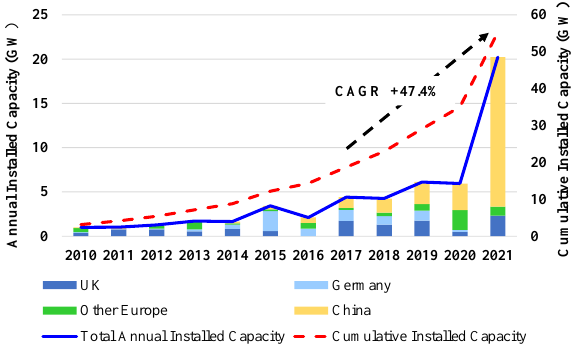
Figure 1. Annual installed offshore wind capacity (left axis) and cumulative capacity in GW (right axis) by country from 2010 to 2021.